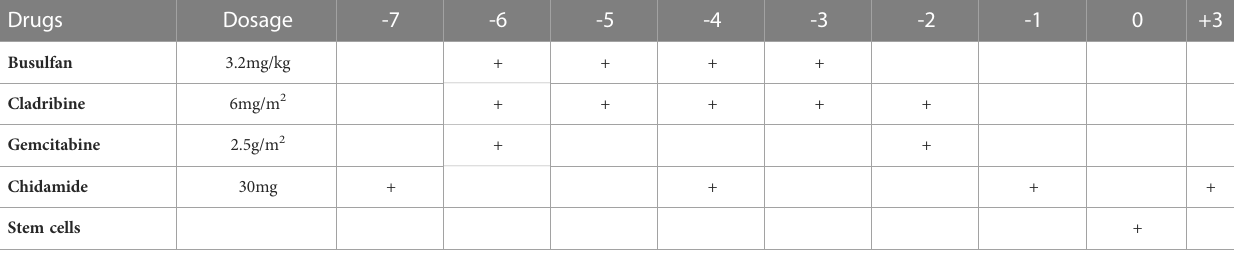
TABLE 1 Conditioning regimen of ChiCGB.